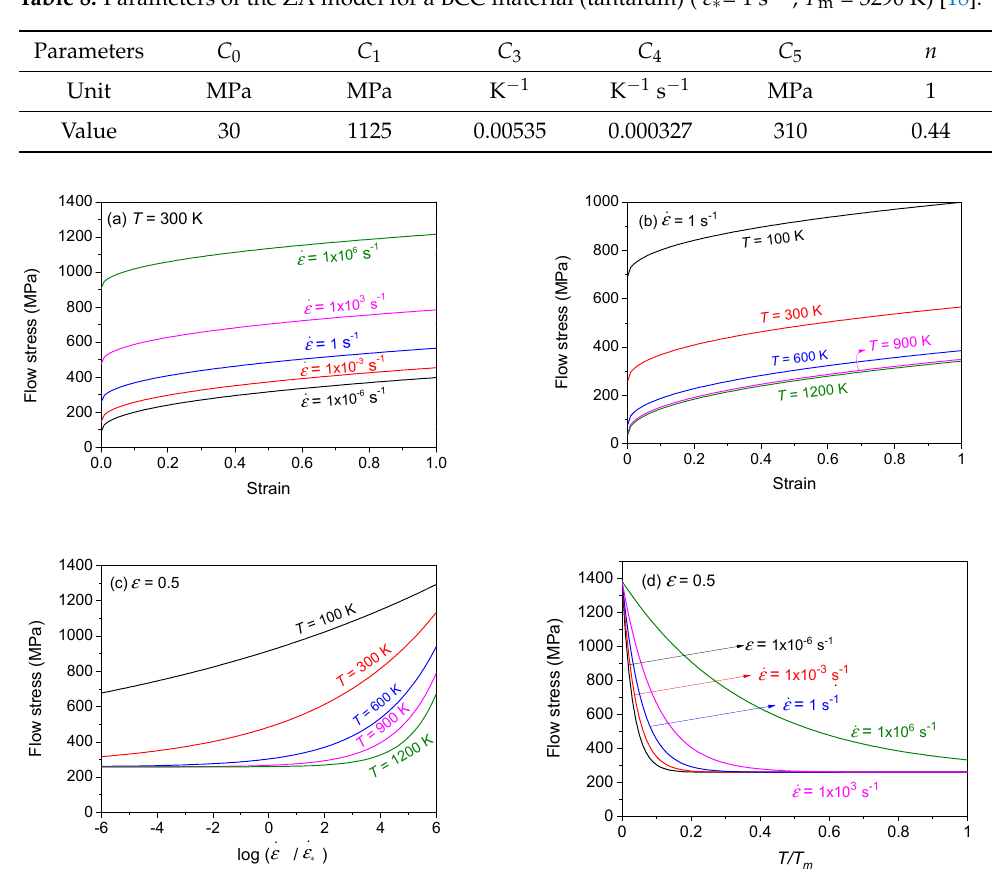
Figure 17. Flow stress–strain curves predicted for tantalum (BCC) using the ZA model ( a ) at 300 K for different strain rates and ( b ) at 𝜀(cid:4662) = 1 for different temperatures. Change in flow stress at 𝜀 = 0.5 ( c ) with log ( 𝜀(cid:4662) / 𝜀(cid:4662) ∗ ) for different temperatures and ( d ) with T / T m for different strain rates ( 𝜀(cid:4662) ∗ = 1 s − 1 , T m = 3290 K).